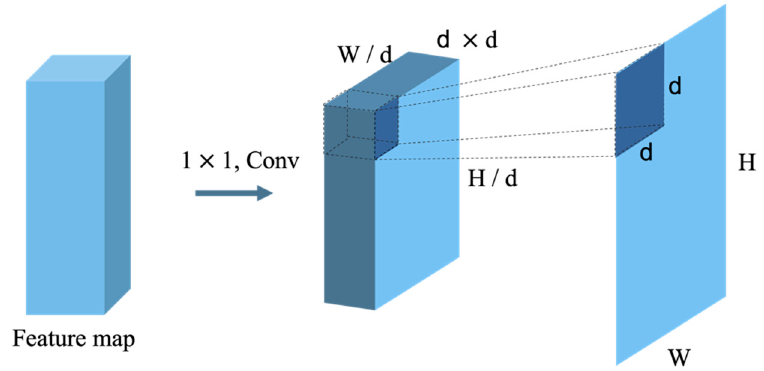
Figure 2. The illustration of DUC.